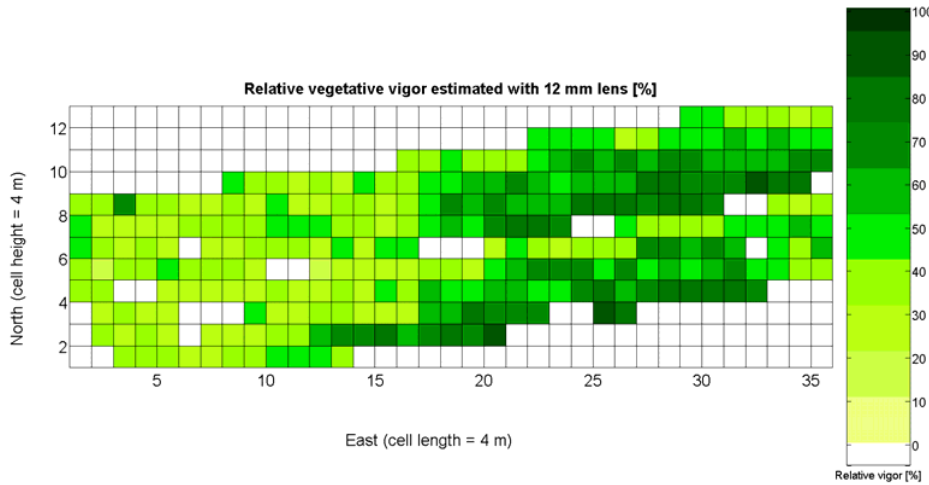
Figure 8. CB map of relative vine vigor estimated with a 12 mm lens: V-12 (%).